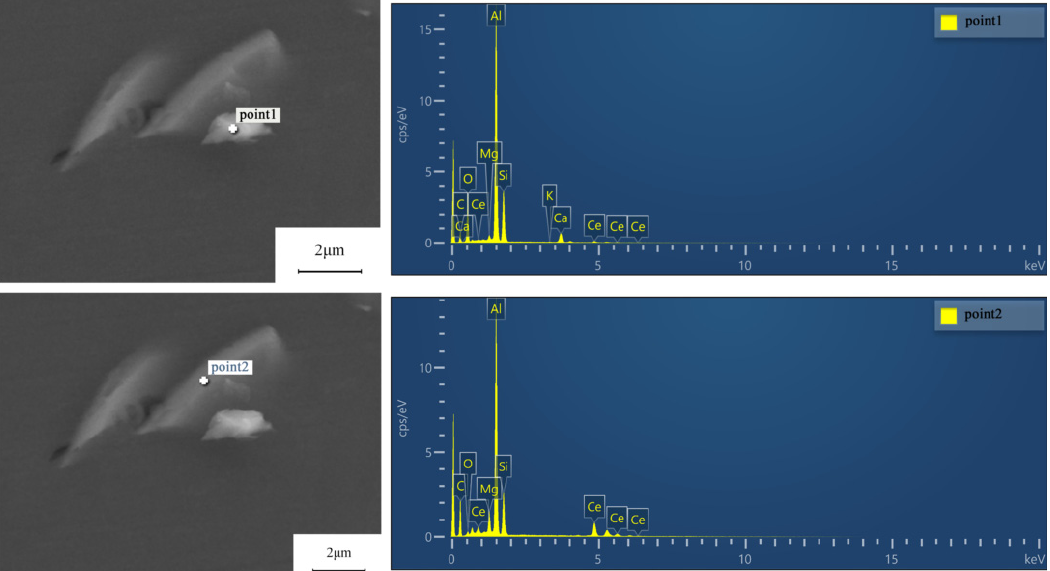
Figure 7. Ce-rich intermetallic compounds (Ce-IMCs). ( a ) Point 1 and EDS analysis, ( b ) Point 2 and EDS analysis.